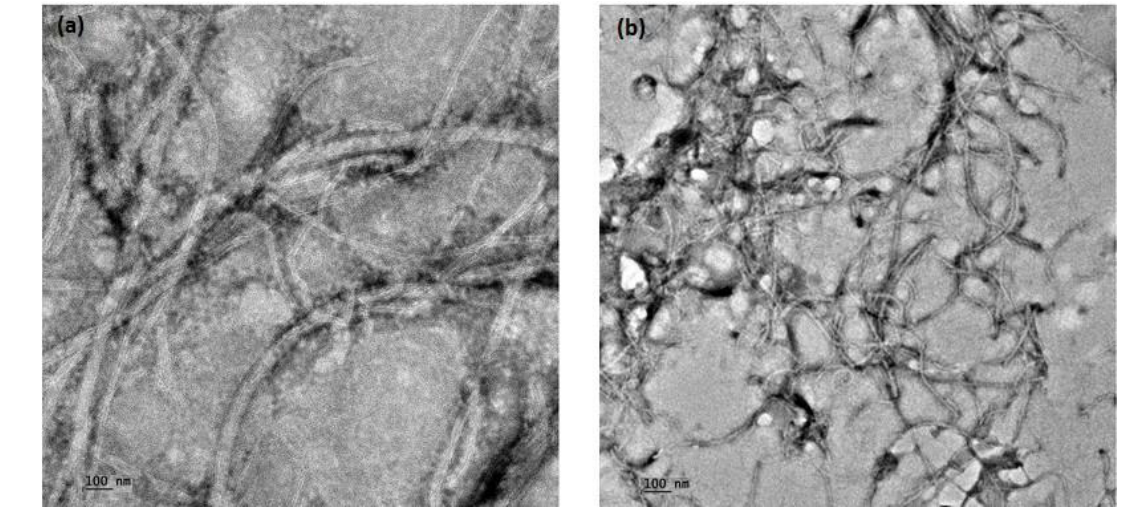
Figure 2. ( a ) TEM image of wsMWCNTs and ( b ) GNP conjugated wsMWCNTs.